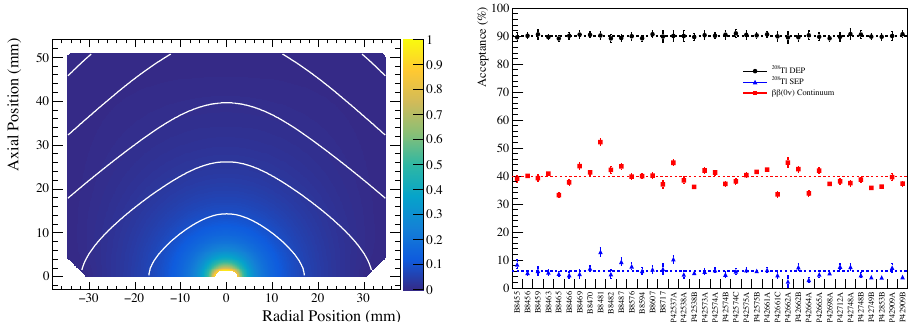
FIG. 8. Color online. The single-site waveform from Fig. 6 (black) compared to an event in the same detector of the FIG. 7. Color online. The acceptance for each detector in same calibrated energy containing a delayed charge compo- FIG. 6. Color online. Shown in black are example single-site DS6a calibration data for events from the 1593 keV DEP nent (red). The waveforms are aligned at 97% of the maxi- (solid) and multi-site (dashed) events from the 2615 keV 208 Tl and 2104 keV SEP of the 2615 keV 208 Tl decay are shown in mum which is the time reference for the shaded regions that peak from calibration data for an enriched PPC detector. The black and blue respectively. Shown in red is the acceptance of are used in computing the DCR slope parameter. current waveforms are shown in red with blue horizontal lines Compton scattering events from the calibration source with indicating the maximum current. While the amplitudes of energy in a 100-keV-wide window centered on the Q-value of the voltage waveforms are the same, the maximum current 2039 keV. The errors shown are statistical only, and the hor- amplitude is significantly lower for multi-site events. izontal lines indicate the mean value for all calibrated detec- tors, including natural detectors. The detector serial numbers are shown as the horizontal axis labels with natural detectors grouped on the left and enriched detectors on the right (serial numbers beginning with ‘B’ and ‘P’ respectively). Although the detector B8481 has abnormally high acceptance for events outside the DEP, it is a natural detector which is not included in the results of Section VII, except for the purposes of reject- ing multiple-detector events.